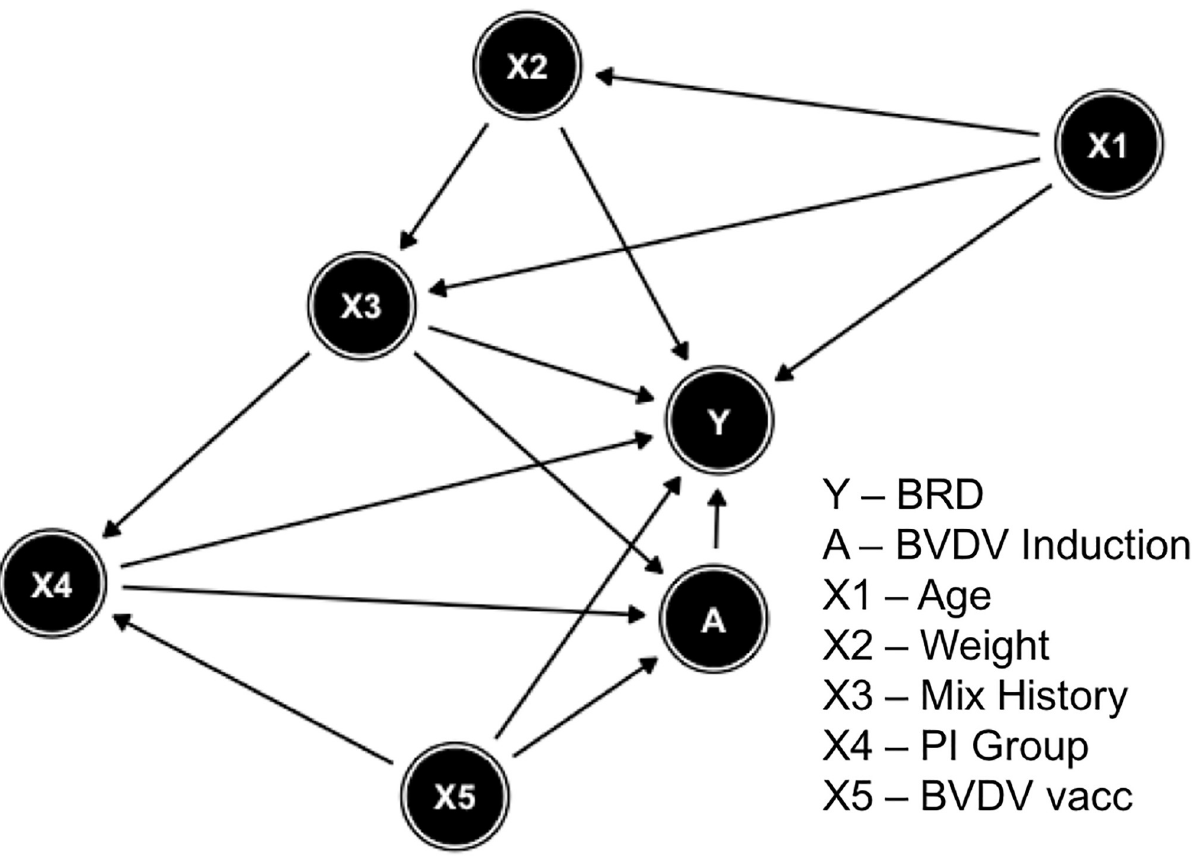
Fig 1. Directed acyclic graph (DAG) of the relationship among outcome, exposure and confounding variables.